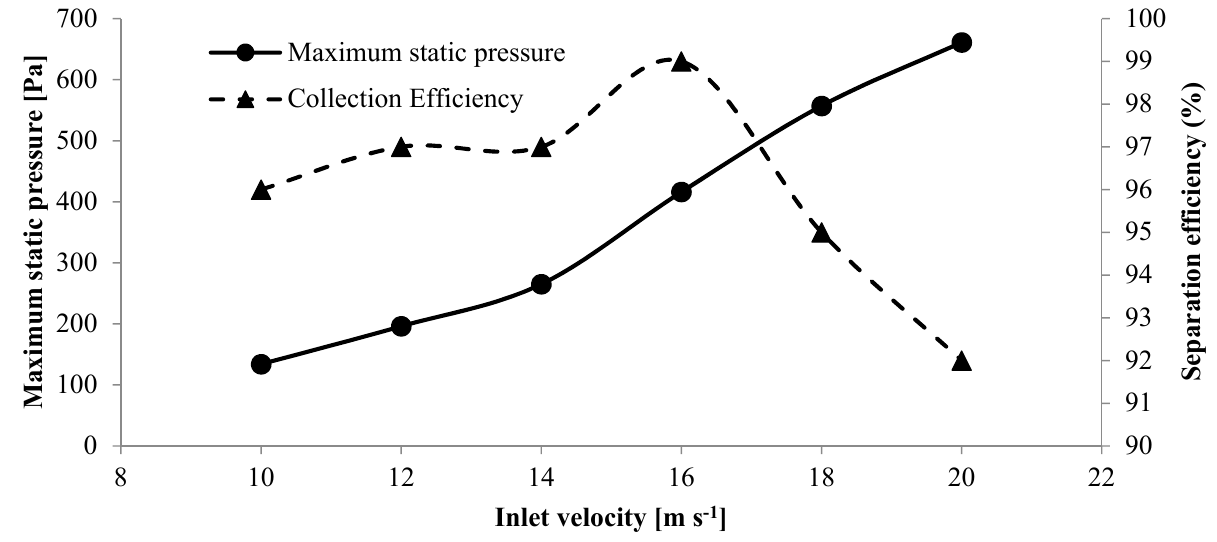
Figure 6. Maximum static pressure and separation efficiency in various inlet velocities.